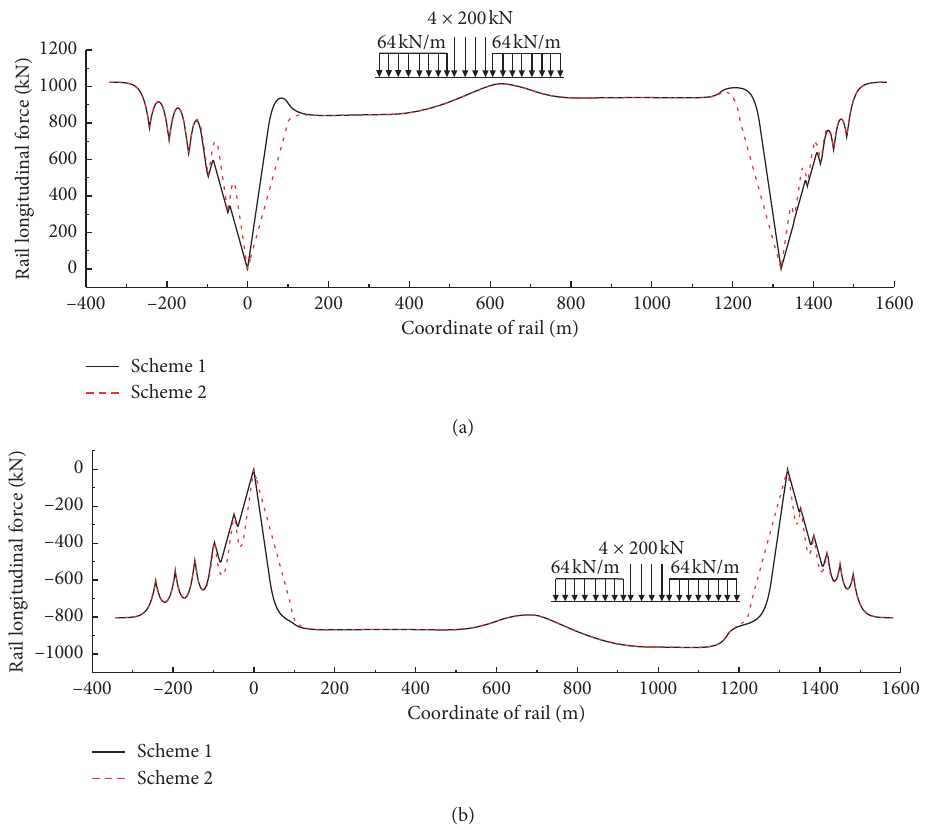
Figure 8: Rail longitudinal force under bending condition. (a) Temperature drop and bending loads. (b) Temperature rise and bending